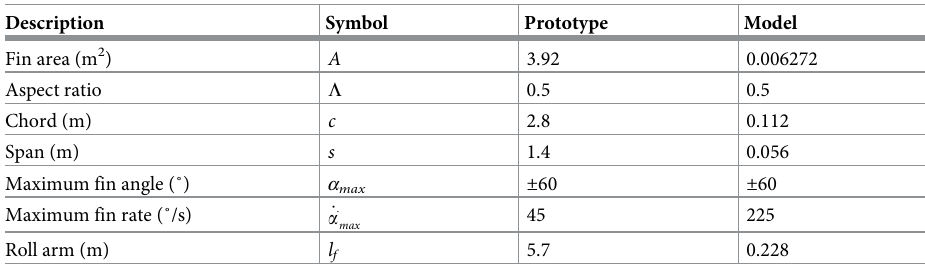
Table 2. Main parameters of the